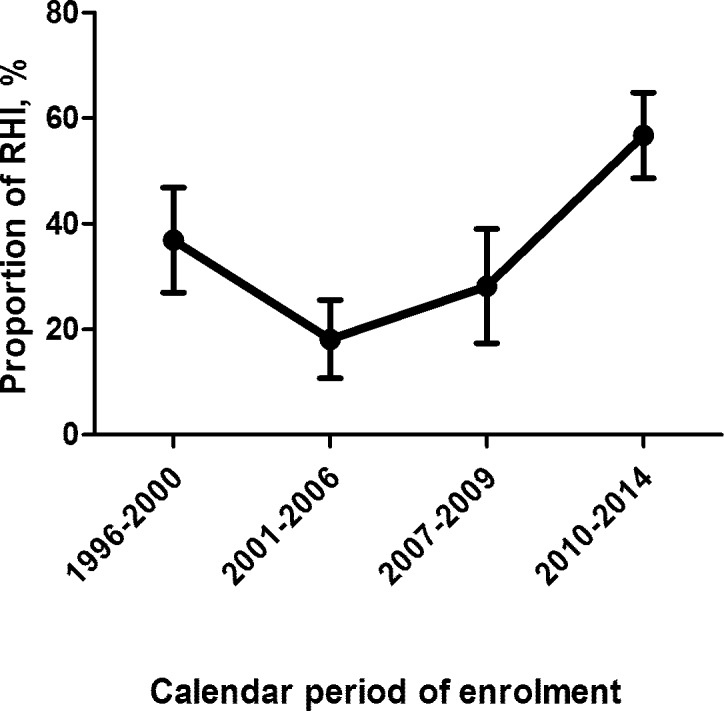
Proportion of Recent HIV Infections by calendar period of enrolment.The graph illustrates the proportion of Recent HIV Infections (RHI), defined as a positive HIV serological test within 12 months since the last negative one, according to calendar period of seroconversion (1996–2000, 2001–2006, 2007–2009, 2010–2014). X-axis: calendar periods, Y-axis: proportion of RHI in percentages.